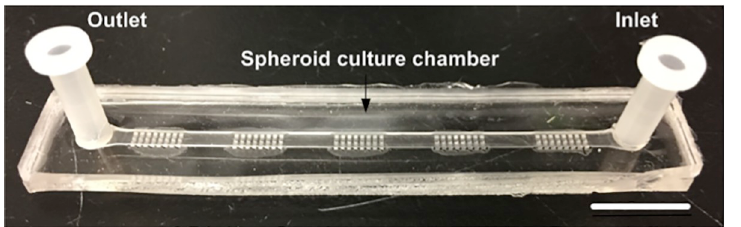
Fig 2. Design of PDMS microfluidic device developed for the culture of 3D spheroids and drug testing. Each chip is comprised of five sections of 24 wells, containing 120 wells. Each well has a dimension of 500 × 500 × 500 μ m 3 . The scale bar is 1